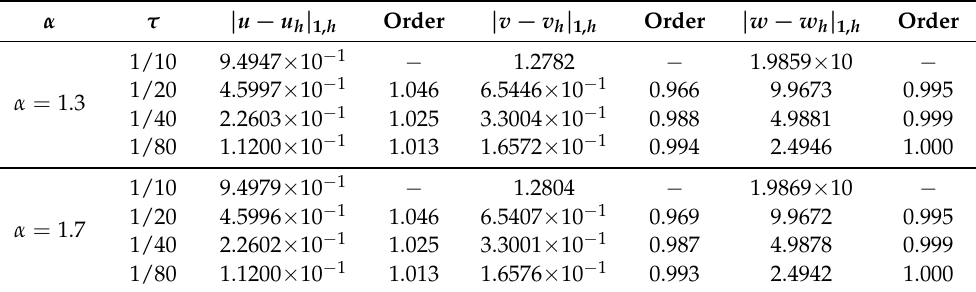
Table 2. H 1 -harf-norm errors and temporal convergence order of MFVE